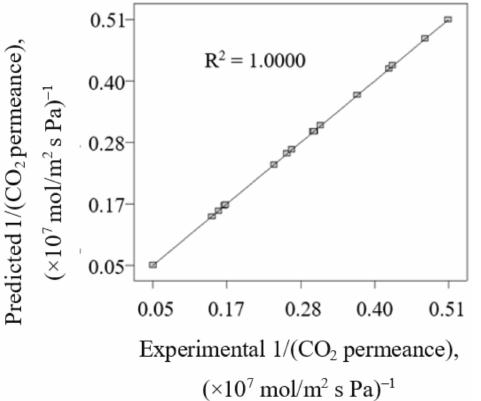
Figure 1. The comparison between predicted 1/(CO 2 permeance) attained by using Equation (6) with the experimental 1/(CO 2 permeance).